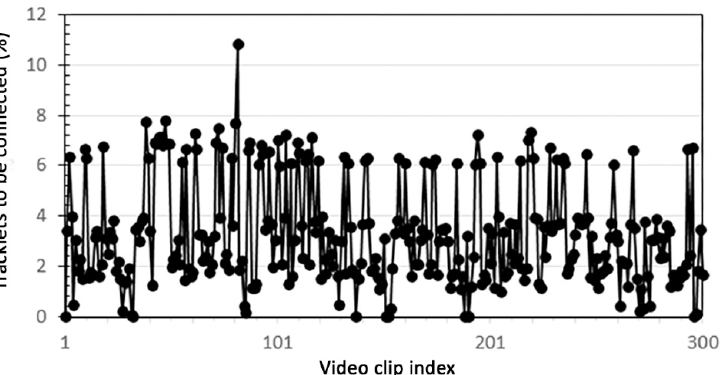
Figure 7. The percentage of disconnected KLT tracklets (which are the tracklet candidates to be connected) for 300 video clips from the CUHK crowd data set.